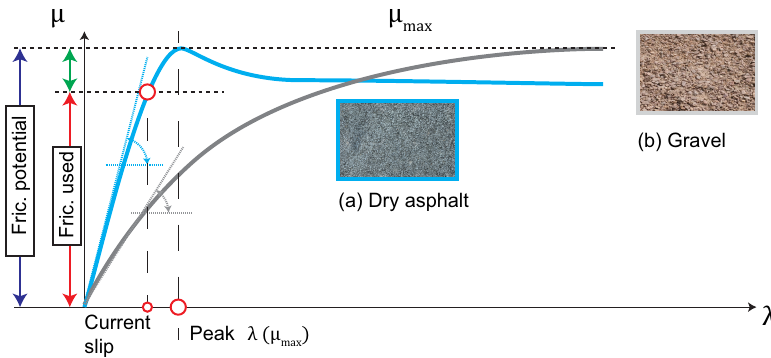
Figure 7. Friction versus longitudinal slip curves representative of ( a ) high mu asphalt and ( b ) gravel surface. Curves generated with the tyre parameters presented in